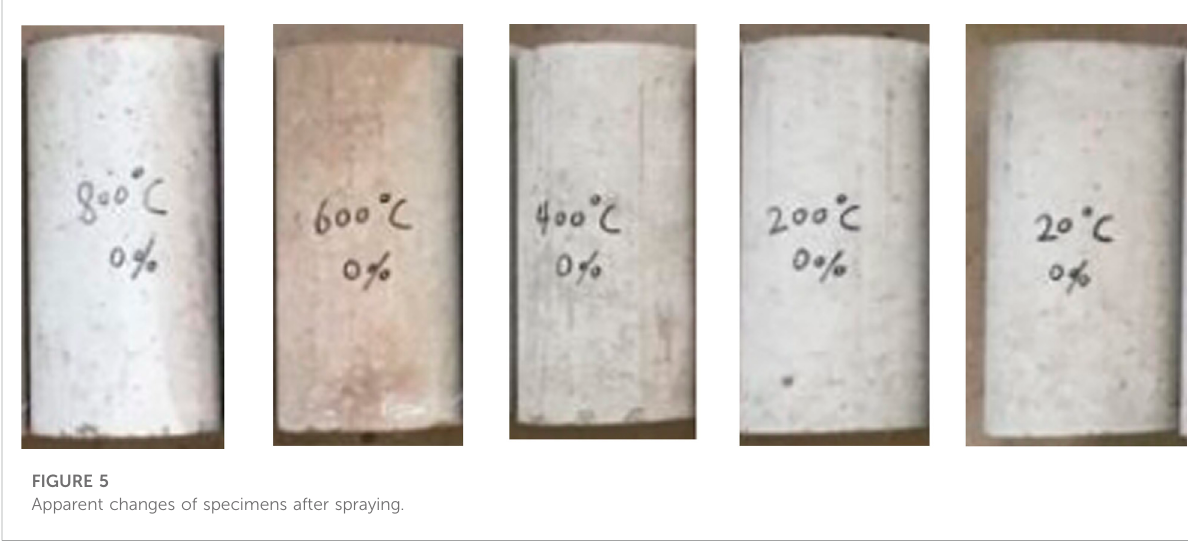
FIGURE 5 Apparent changes of specimens after